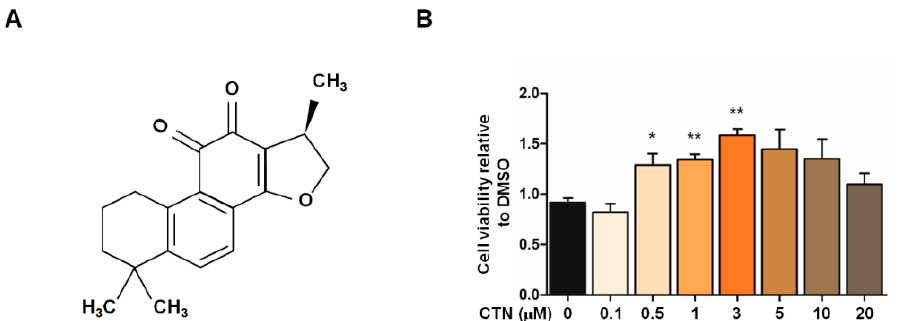
Figure 2. Cytoprotective effects of cryptotanshinone (CTN) on MG132-induced cellular stress in GS-hiNPCs. ( A ) Chemical structure of CTN from the root of Salvia miltiorrhiza Bunge (Danshen). ( B ) Cytoprotective effects of CTN on GS hiNPCs with the MG132-induced stress condition. Data are mean ± standard error of means (SEM) of at least three independent experiments. p -values were analyzed using the unpaired two-tailed Student’s t -test (* p < 0.05, ** p < 0.005, *** p < 0.001).